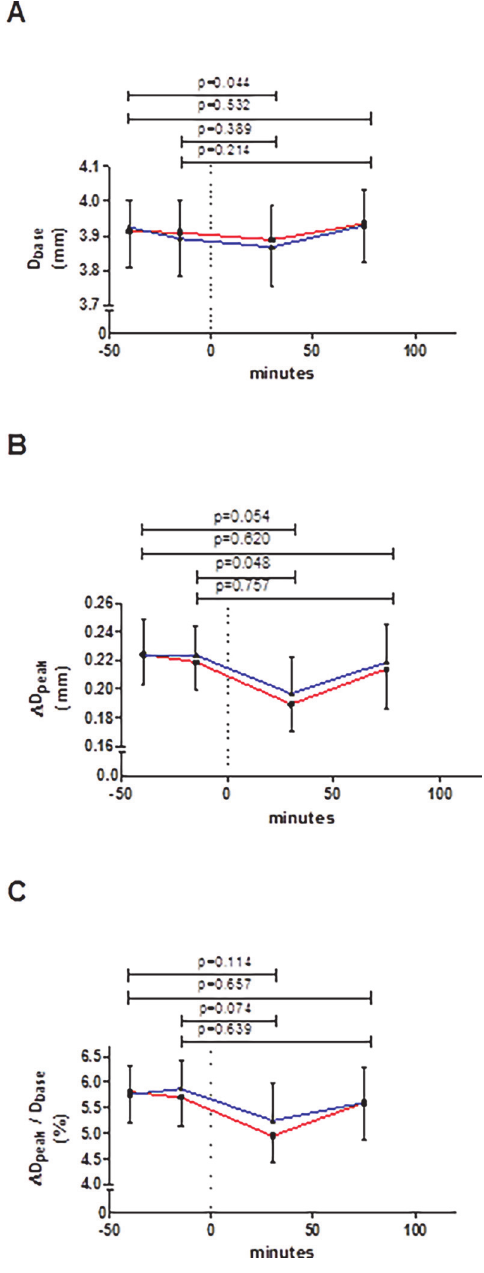
Figure 5. Changes in (A) baseline diameter and (B) the absolute and (C) the relative (i.e. %FMD) peak changes in brachial artery diameter. Glucose was ingested at time-point 0 minutes (dashed vertical line). Red line represents session 1 and blue line session 2; whiskers indicate standard error. Data did not differ between sessions at any corresponding time-point (all p-values (cid:3) 0.568, n = 22). The p-values on top of the graphs refer to differences between pre and post glucose intake (of the mean of both sessions). Abbreviations as defined in Table 1.